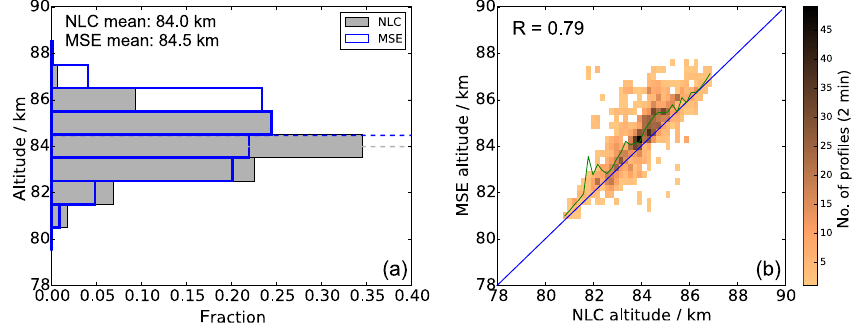
Figure 5. Same as Fig. 3, but for the upper edges of NLCs and MSEs ( z up